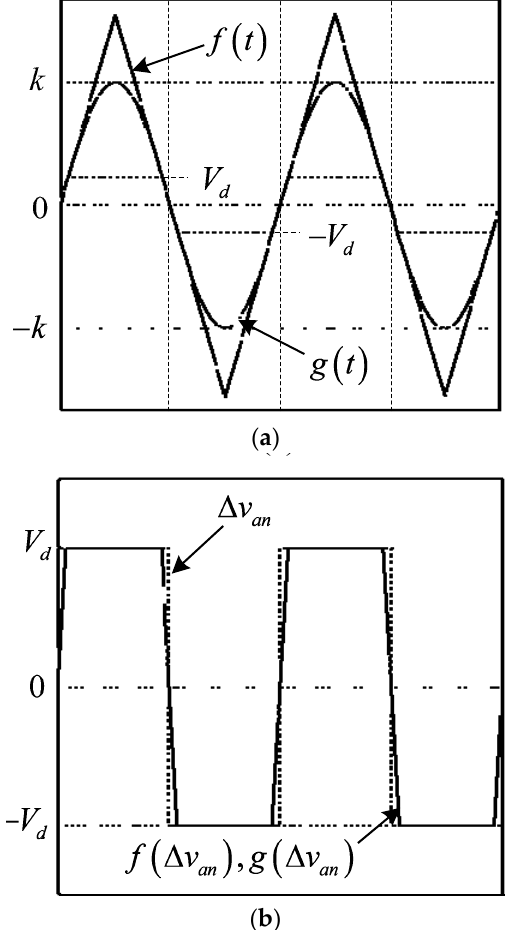
Figure 10. Proposed TCV implementation strategy; ( a ) triangle waveform function f ( t ) and sinusoidal waveform function g ( t ) with peak k ; ( b ) TCV shapes